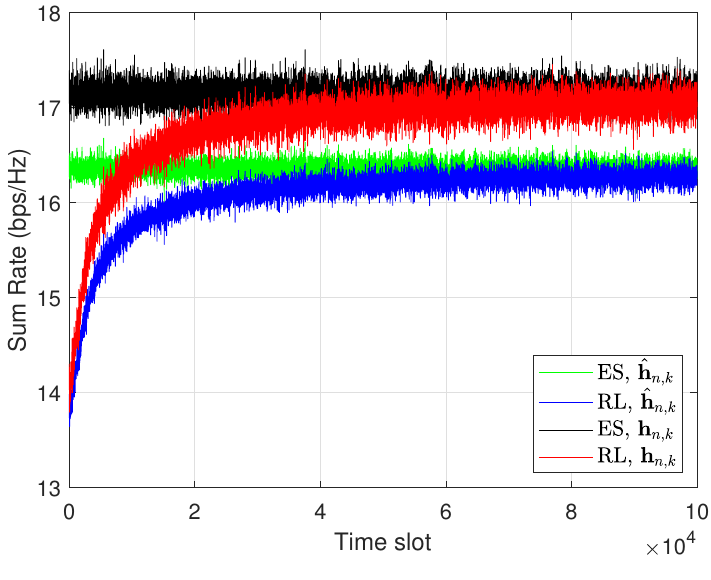
Figure 6. Sum rate of the RL scheme.